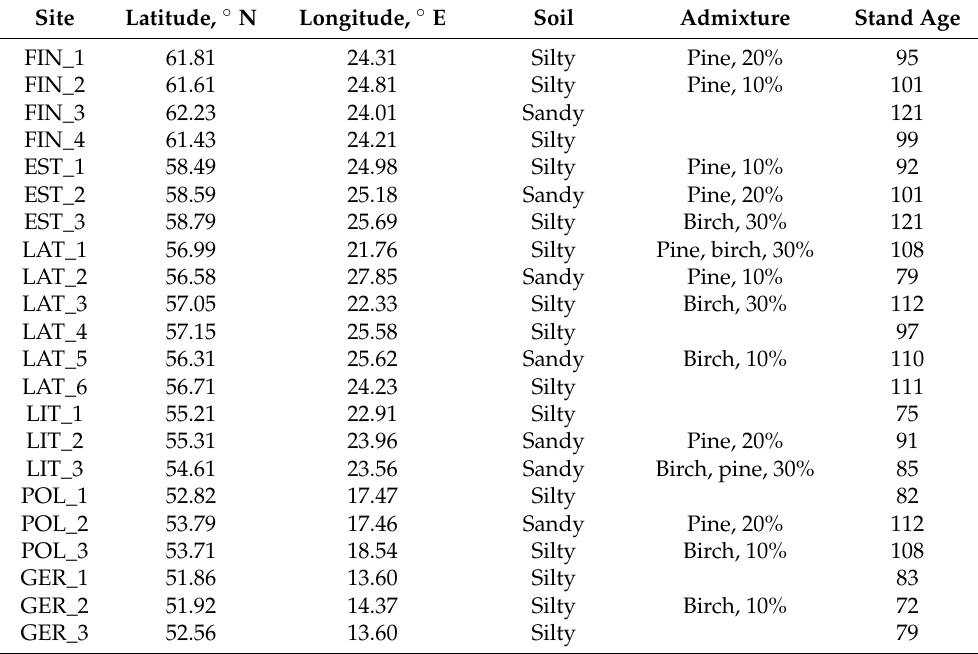
Table 1. Location, soil type, composition (admixture), and age of the sampled stands of Norway